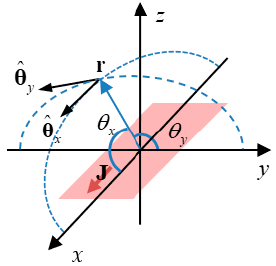
Figure 1. Current sheet and the unit vectors in the coordinate system.